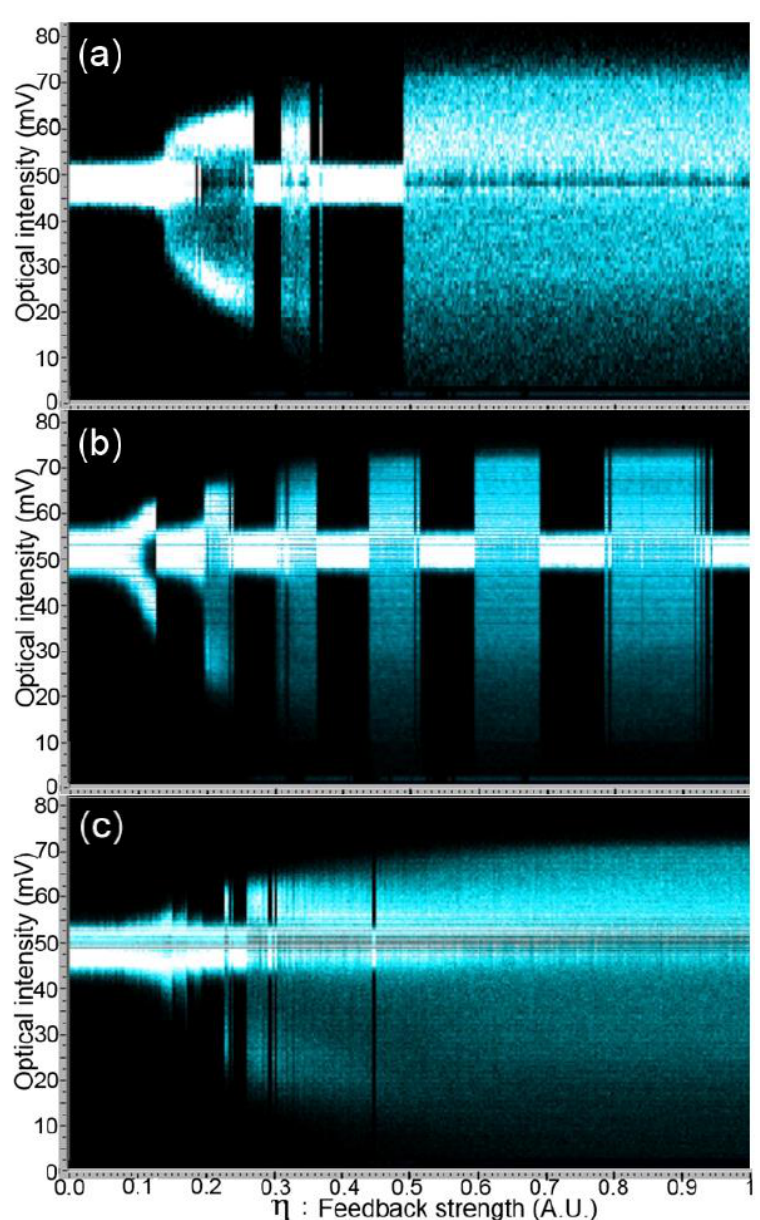
Figure 3. Experimental bifurcation diagrams of a Mitsubishi ML925B11F diode with ( a ) J = 1.58 J th and L = 30 cm, ( b ) J = 1.21 J th and L = 15 cm, and ( c ) J = 1.21 J th and L = 65 cm. From Ref. [22].